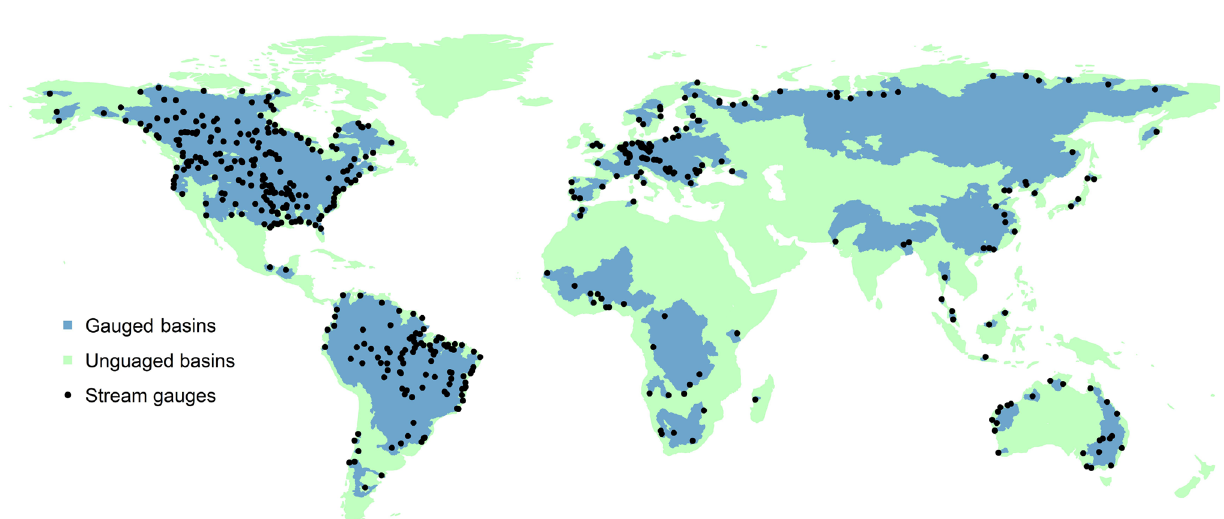
Figure 1. Spatial coverage of gauged and ungauged river basins and location of stream